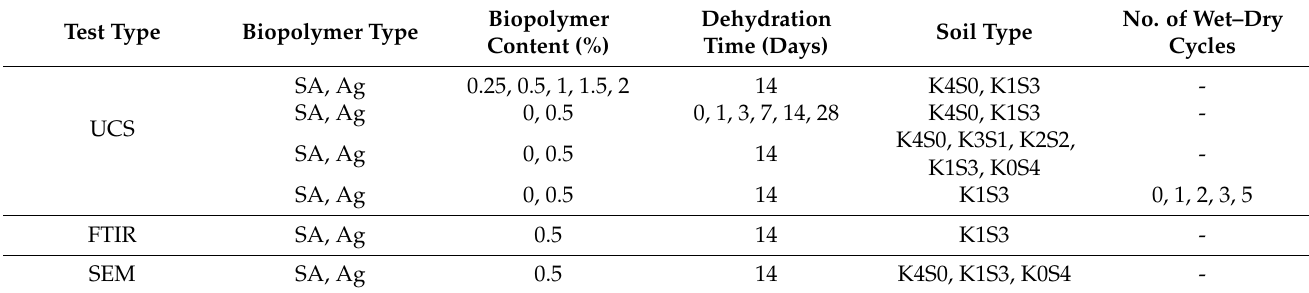
Table 4. Experimental program of the current